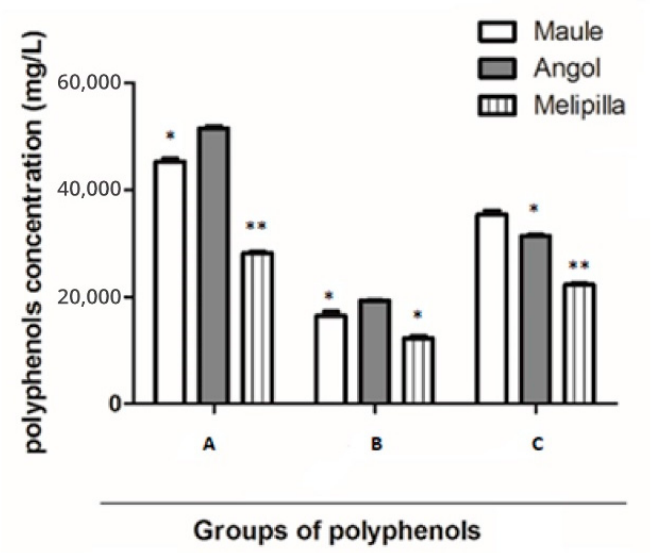
Figure 1. Total compounds quantified by means of colorimetric analysis in PCP1, PCP2 and PCP3. ( A ). Total polyphenols. ( B ). Total flavones and flavonols. ( C ). Total flavanones and dihydroflavonols. Statistical differences: (* p < 0.05), (** p < 0.01). On the other hand, the total content of flavanones and dihydroflavonols, determined by reaction with 2,4-dinitrophenylhydrazine, was in PCP1: 31,397 ± 3 mgg − 1 ; in PCP2: 35,390 ± 2 mgg − 1 and in PCP3: 22,255 ± 3 mgg − 1 . The Maule sample exhibits significant statistical differences in comparison with the other samples, as shown in Figure 2. The mean percentages of the total phenolic compounds means were similar to the results of previous studies